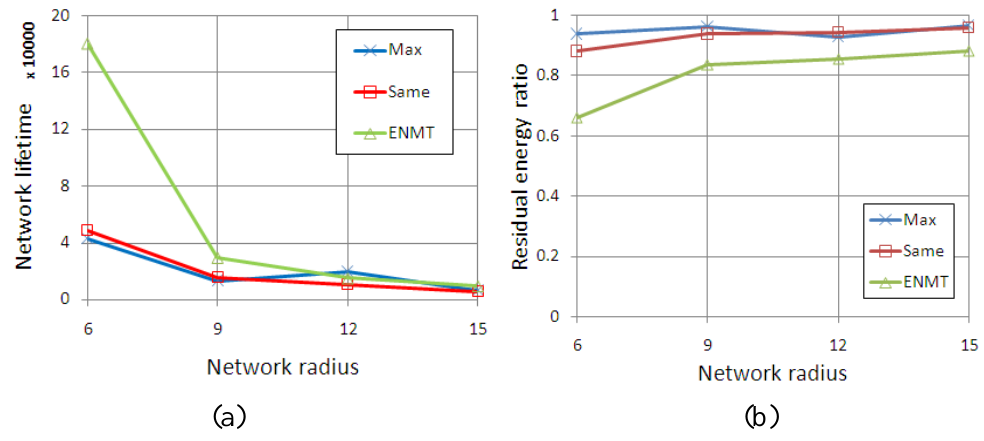
Figure 8. Simulation results (2, 3 and 4). (a) Network Lifetime. (b) Residual energy ratio.